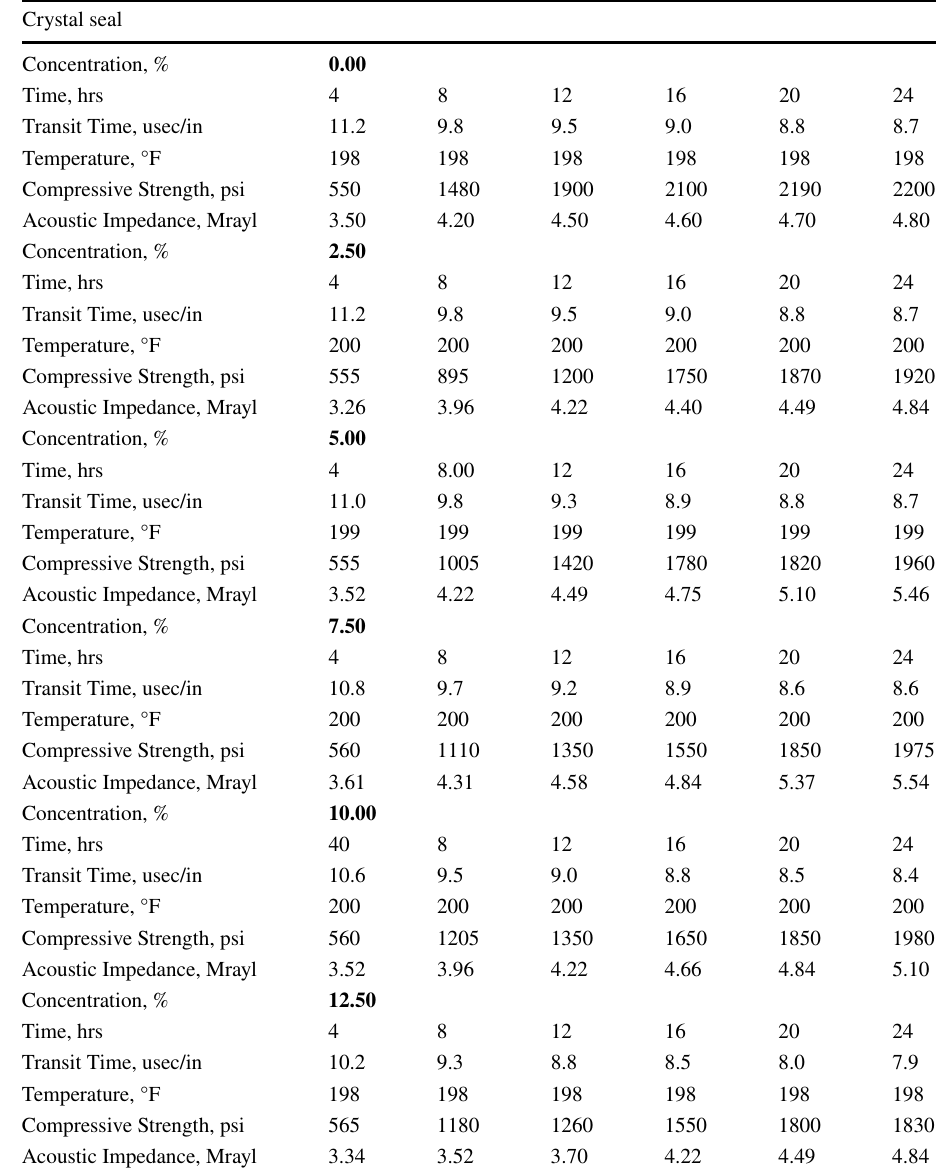
Table 3 Crystal seal test results